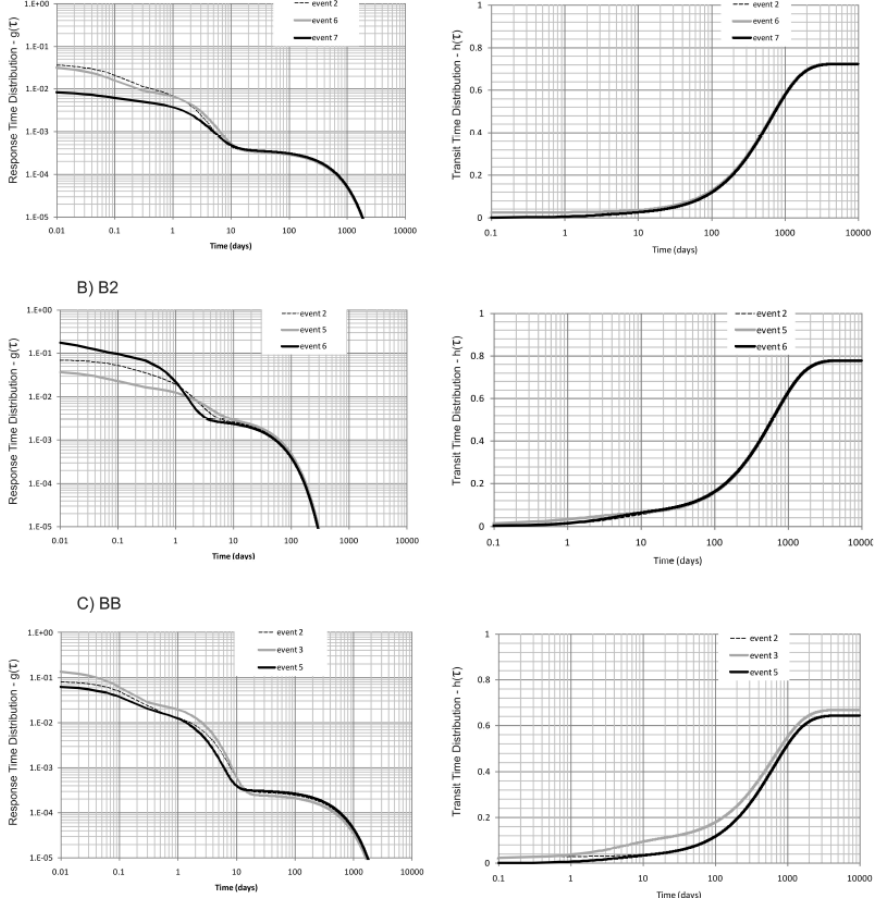
Fig. 6. Probability density function – pdf of Response Time Distribution (RTD – g(T ) ) and cumulative probability density function – pdf of Transit Time Distribution (TTD – h(T ) ) in the left and right columns,